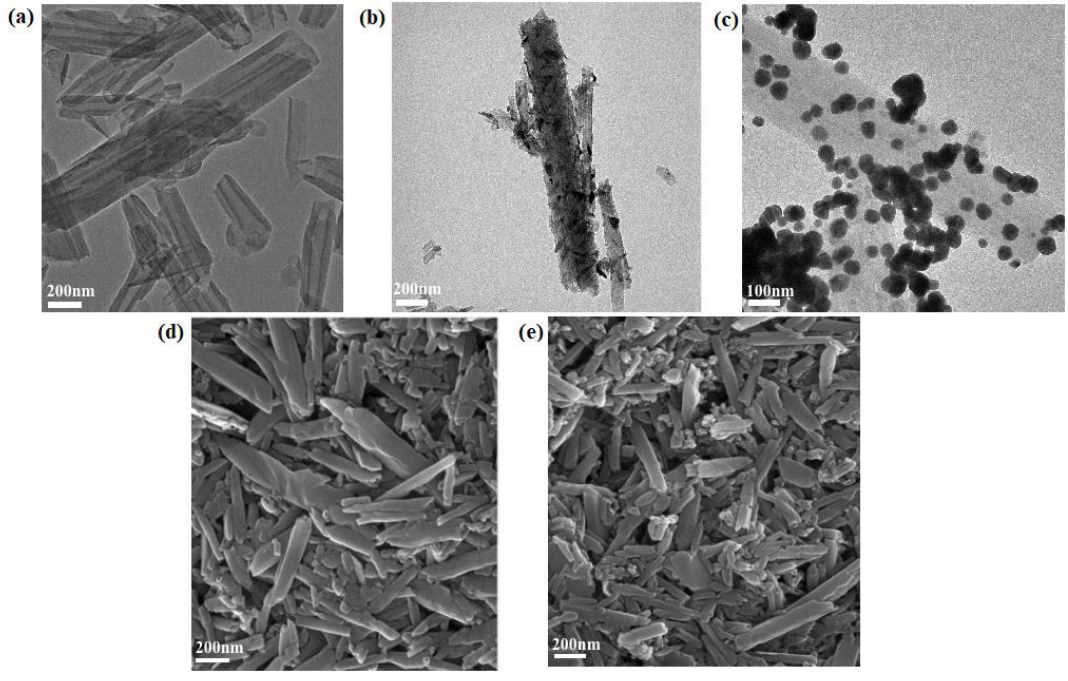
Figure 1. Transmission electron micrographs of HNTs ( a ), MNTs ( b ), and MNTs@AuNPs ( c ); scanning electron micrographs of HNTs ( d ) and MNTs ( e ).